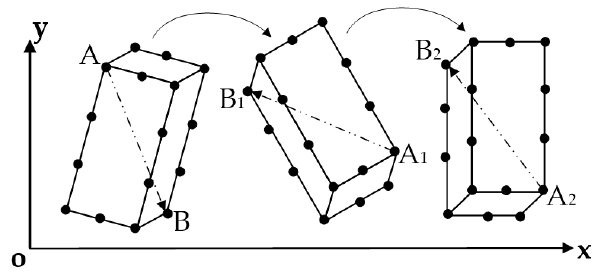
Figure 6. Teaching the automatic control process of the manipulator.